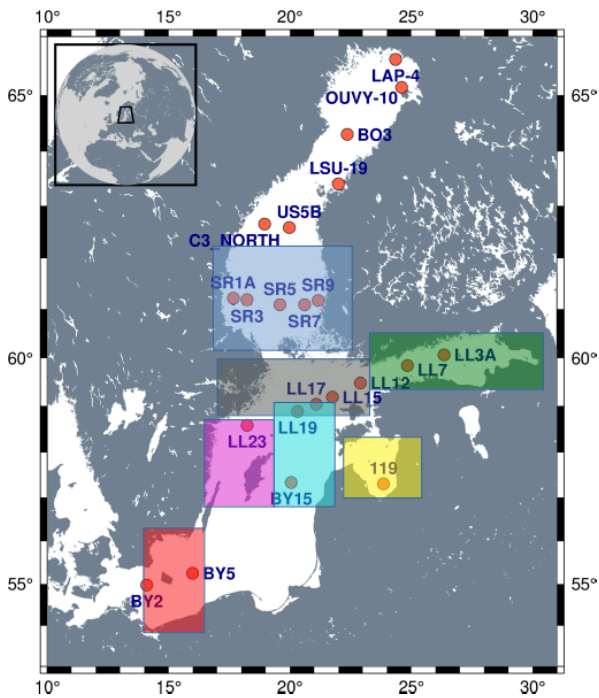
Figure 13. Map of the in situ stations and the boxes used in the analysis of the time series per region. Red: Arkona Basin, grey: northern Baltic Proper, blue: Bothnian Sea, cyan: eastern Gotland Basin, pink: western Gotland Basin, green: Gulf of Finland, yellow: Gulf of